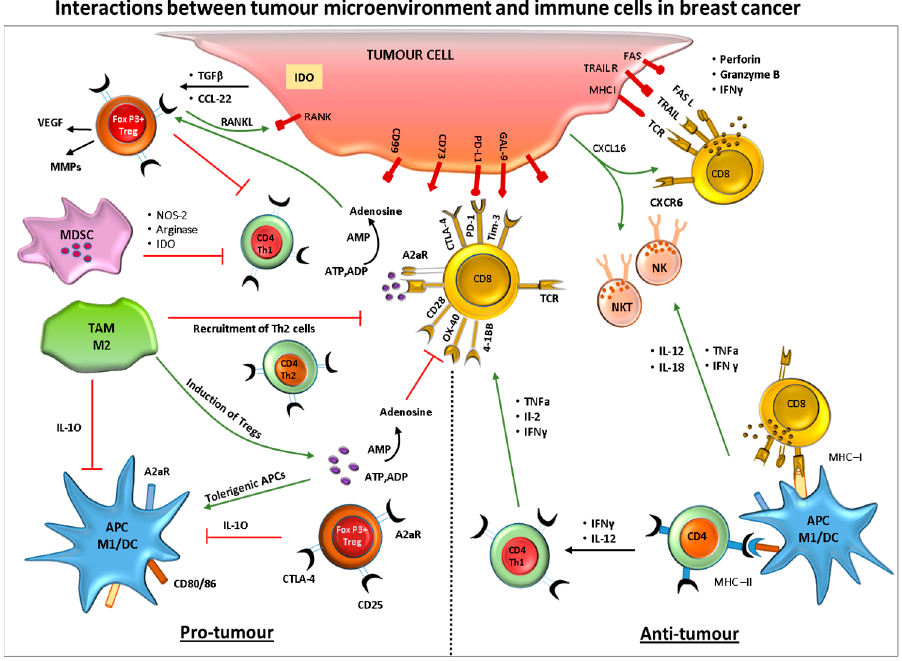
Figure 2. Crosstalk between breast cancer cells and cells of the immune system. The diagram represents the interactions between the tumor and immune cells during pro- and anti-tumor immune responses.